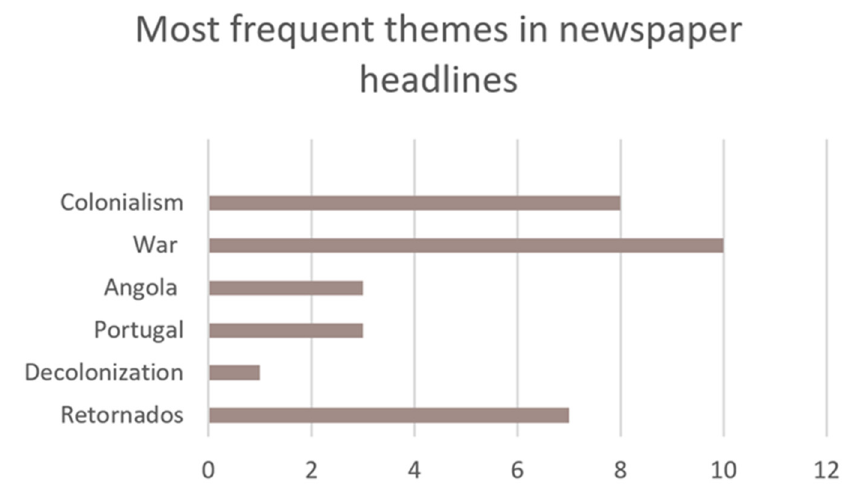
Figure 2. Most frequent topics in newspaper